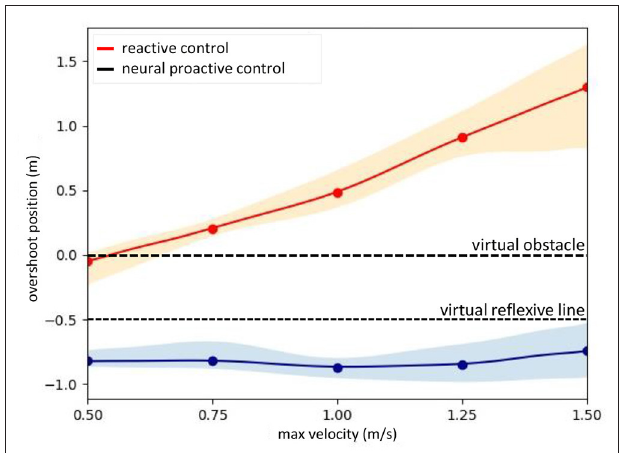
FIGURE 12 | Performance comparison of a simulated IRIS UAV ( Supplementary Figure 1 ) when flying with speed control using the neural proactive control (NPC, blue), MPC (green), or conventional reactive control (orange). The graph was plotted using the maximum overshoot position of the UAV while flying at different maximum speeds. To observe the distribution of the system, we repeated seven times for each